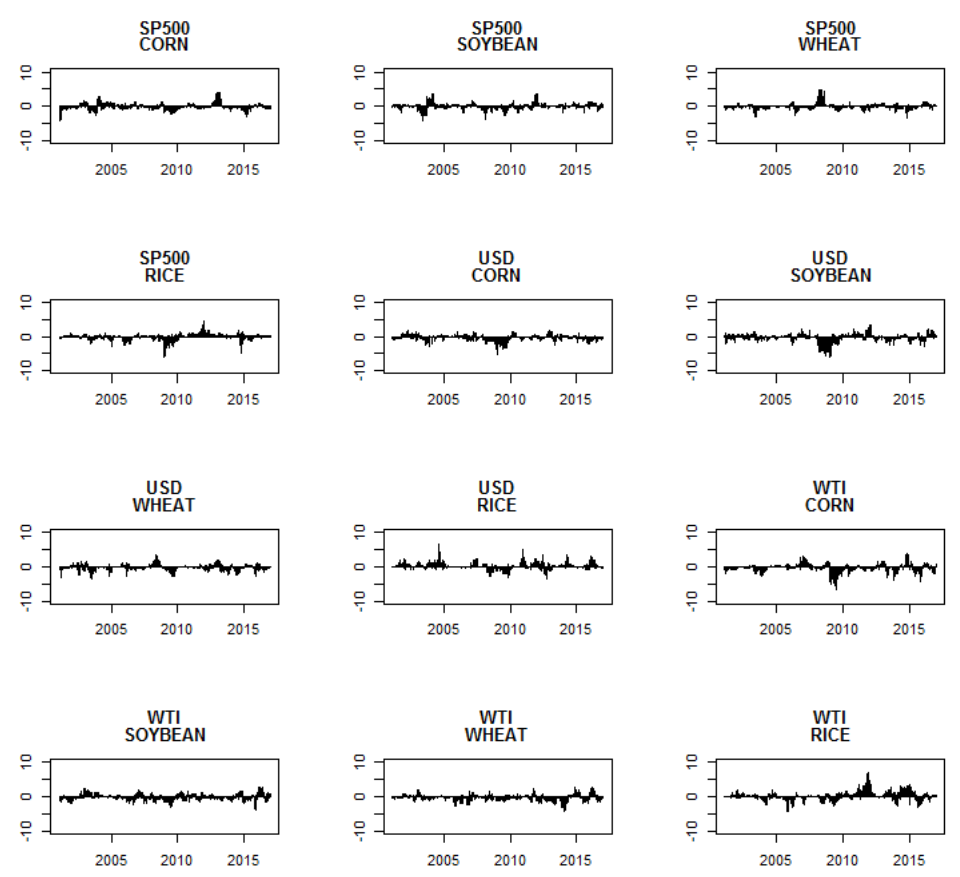
Figure 6: Pairwise net volatility spillovers from the US stock (SP500), energy (WTI) and foreign exchange (USD) markets to the food markets (the lasso